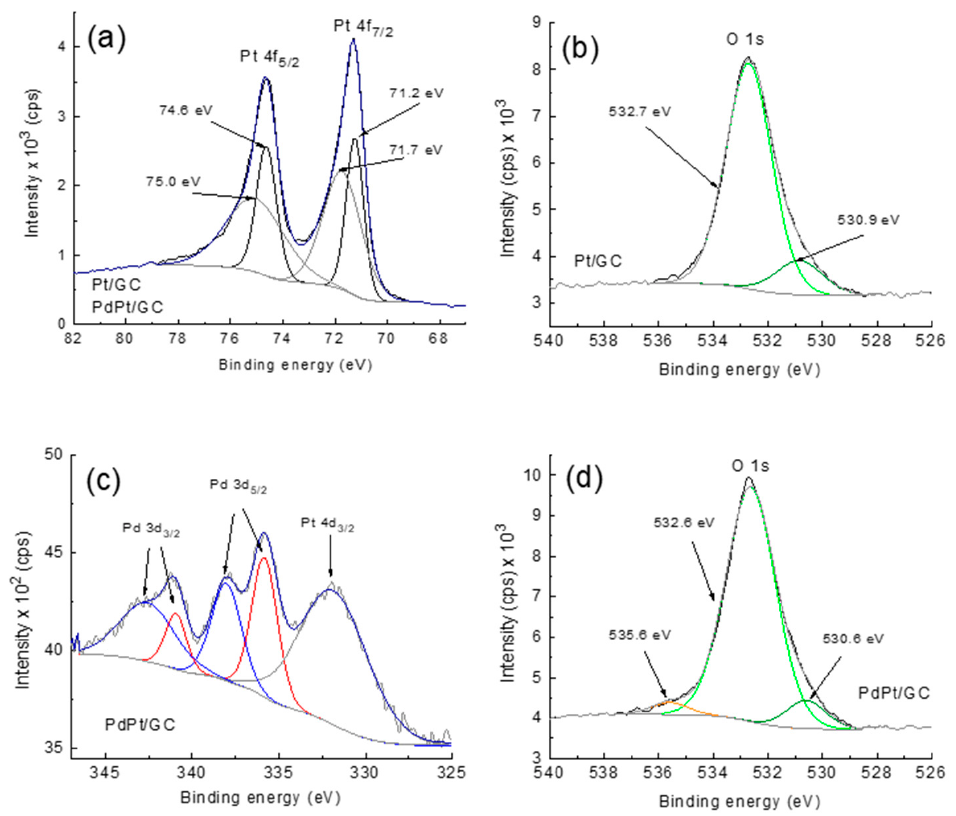
Figure 4. High-resolution XPS spectra of ( a ) Pt 4f for both Pt/GC and PdPt/GC; ( b ) O 1s for Pt/GC; ( c ) Pd 3d and Pt 4d 3/2 for PdPt/GC; and ( d ) O 1s for PdPt/GC. ( c ) Pd 3d and Pt 4d 3/2 for PdPt/GC; and ( d ) O 1s for PdPt/GC.